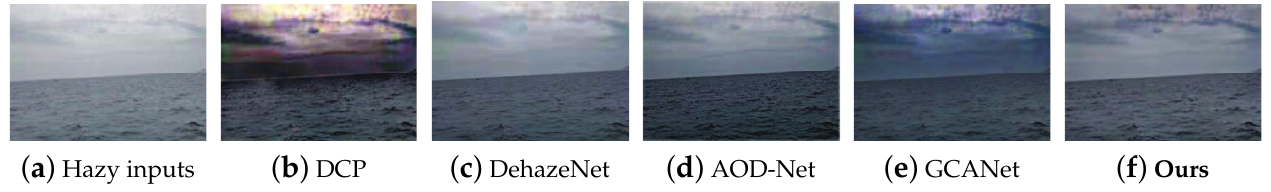
Before/after dehazing Detection success (sheets)